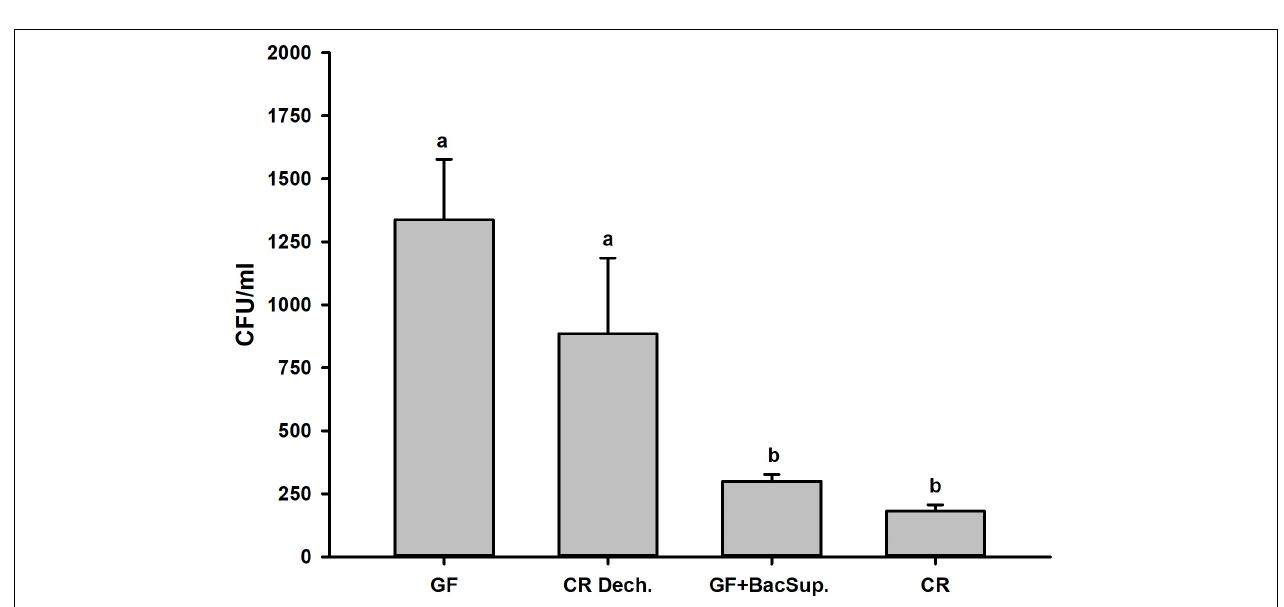
FIGURE 2 | Bacterial clearing ability of the symbiotic (CR Dech., GF BacSup., and CR) and aposymbiotic (GF) RPW